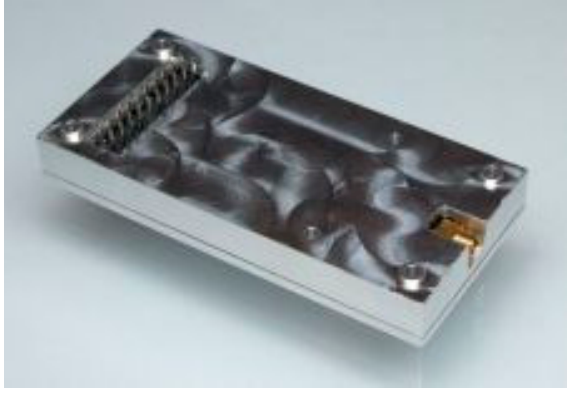
Figure 35. SkyFox Labs piNAV-L1 [57].